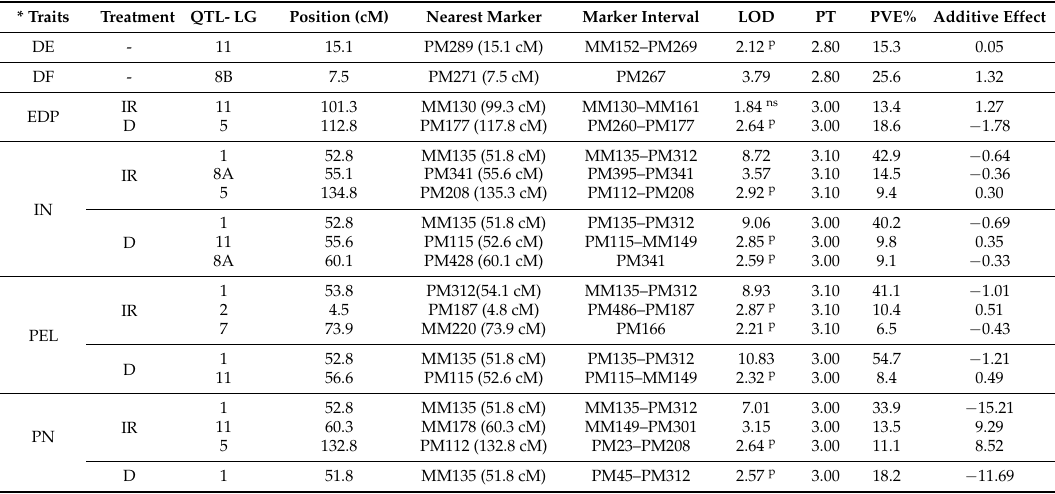
Table 3. The identification of QTL controlling 17 traits involved in agronomy and drought responses in both irrigated and drought treatment F 5 segregating